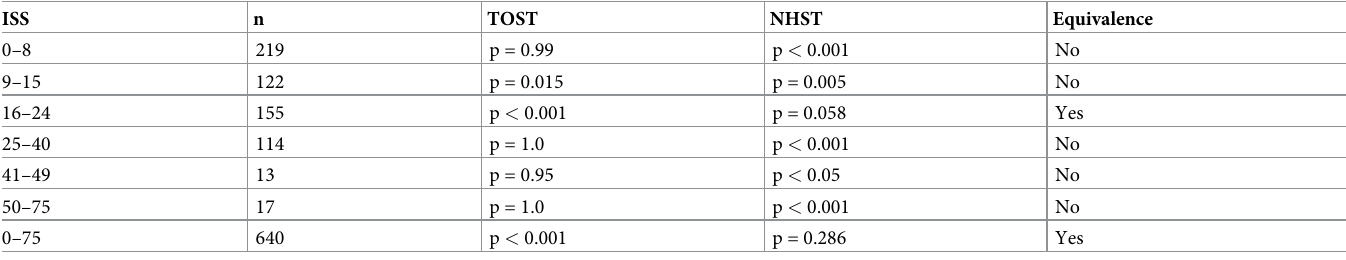
Table 2. Equivalence testing between the automatic and manual ISS calculation.